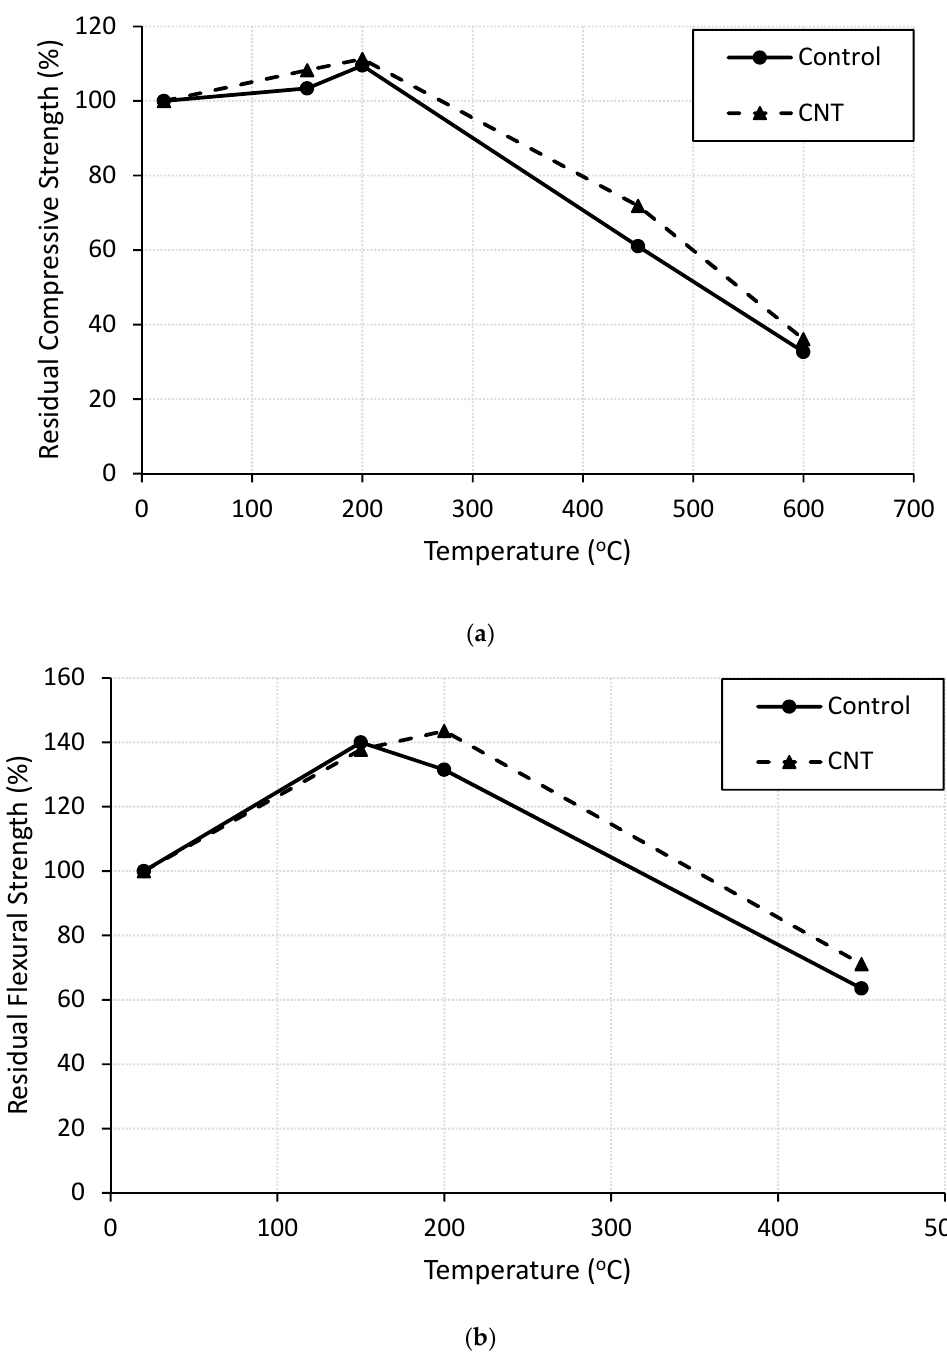
Figure 9. Relative residual strength of control and CNT-reinforced specimens after heating: ( a ) Compressive; ( b ) Flexural.